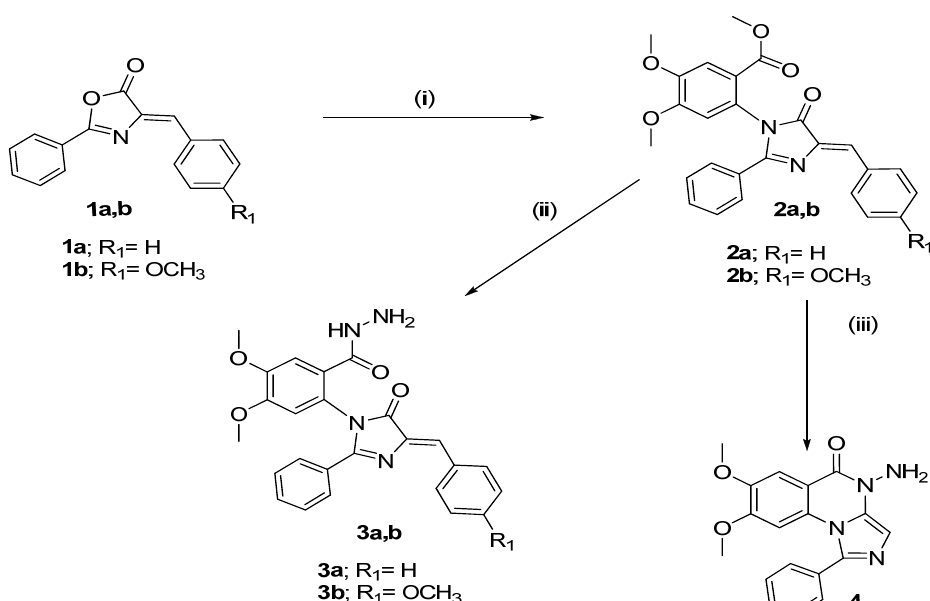
Scheme 1. Synthesis of the target compounds 1 – 4 .